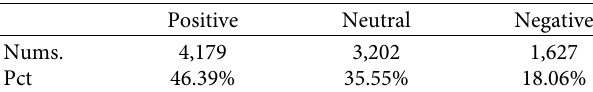
Table 1: Financial entities.